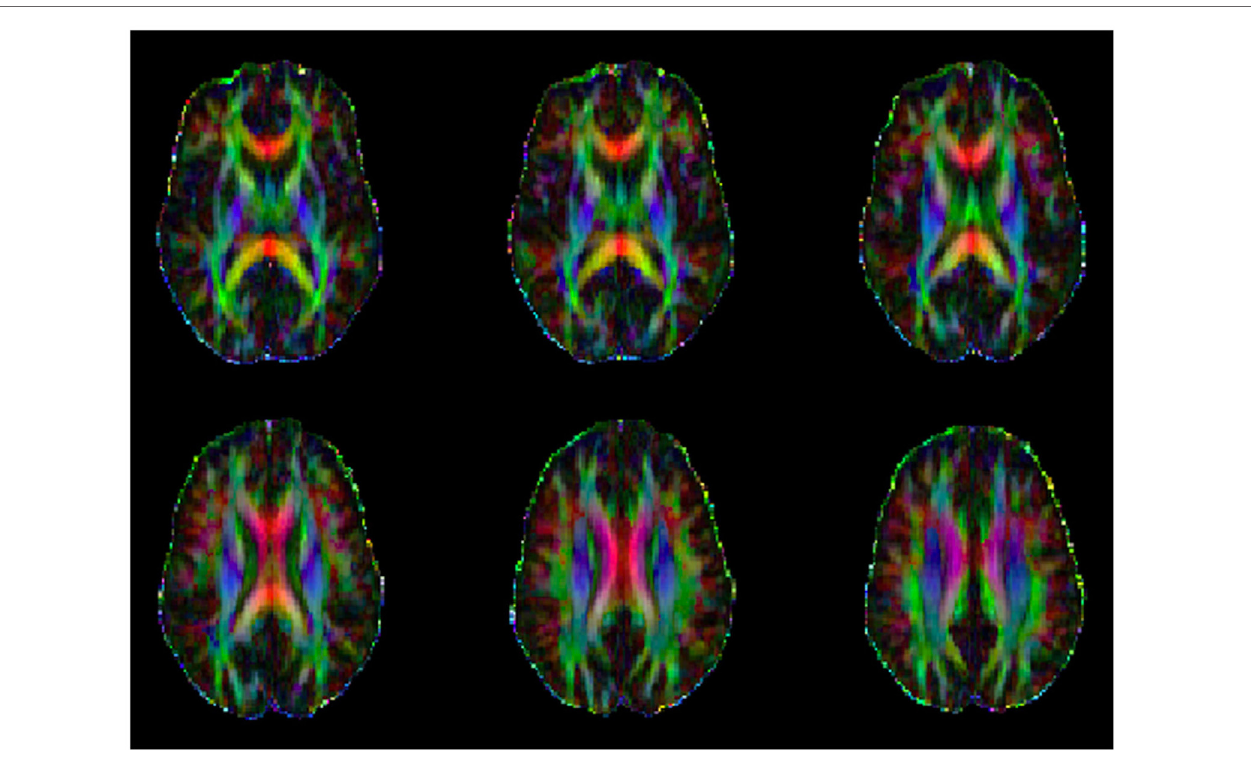
FigUre 2 | example of a series of color orientation fractional anisotropy maps from one study participant where the primary colors represent principal directions of the various white-matter tracks (red: left–right, green: anterior–posterior, and blue: superior–inferior)